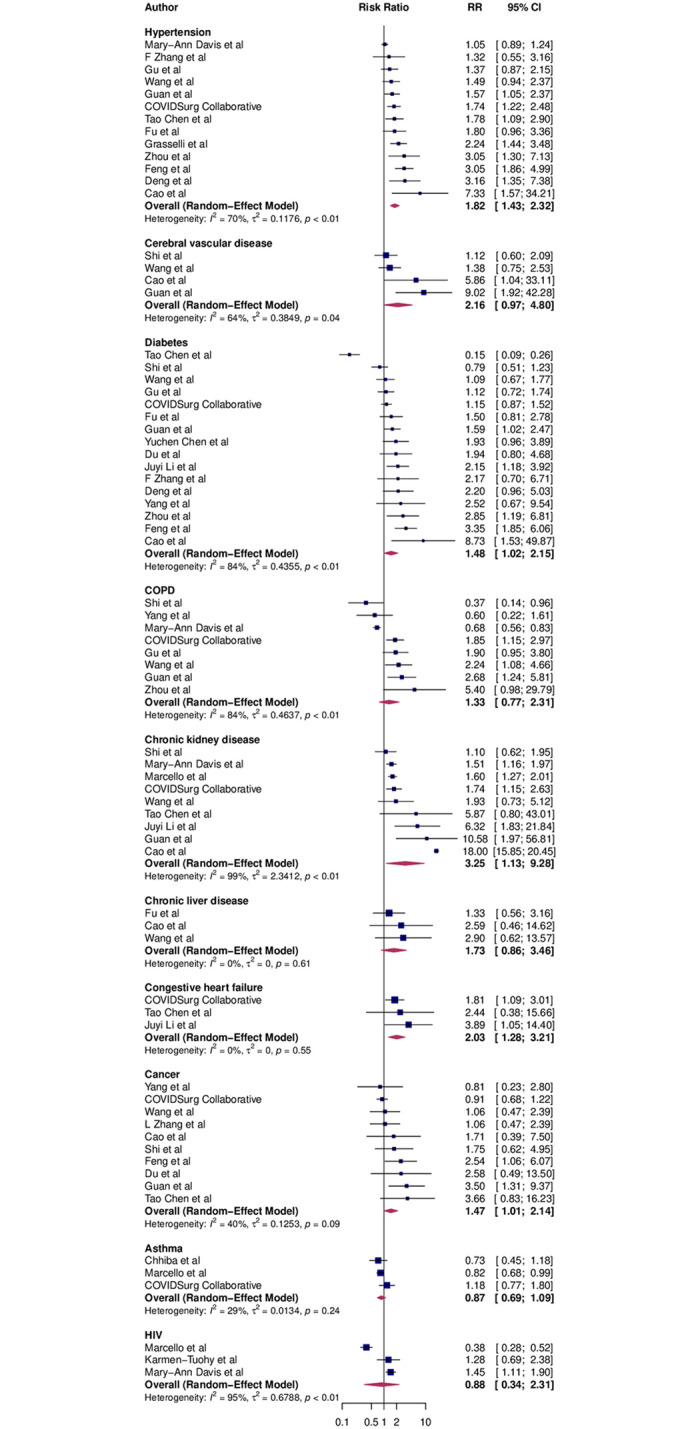
Association of 10 other comorbidities disease and mortality risk from COVID-19.Blue squares and their corresponding lines are the point estimates and 95% confidence intervals per each study. Maroon diamond represents the pooled effect estimate.